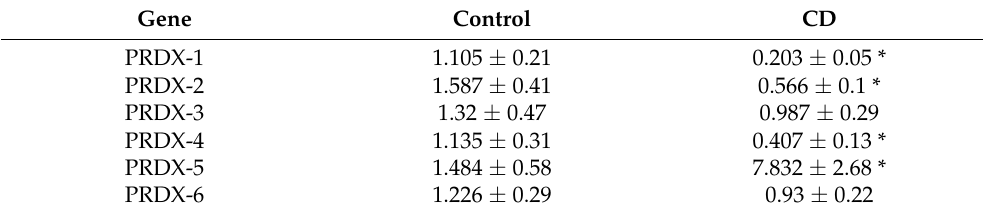
Table 4. The relative mRNA expression values of the PRDXs (1–6) in the duodenal tissue. The relative mRNA expressions were calculated with the 2 − ∆∆ CT method and normalized to GAPDH ( n = 7/7). Data were expressed as mean ± SEM. * p < 0.05 versus the control group (CD: celiac disease group).